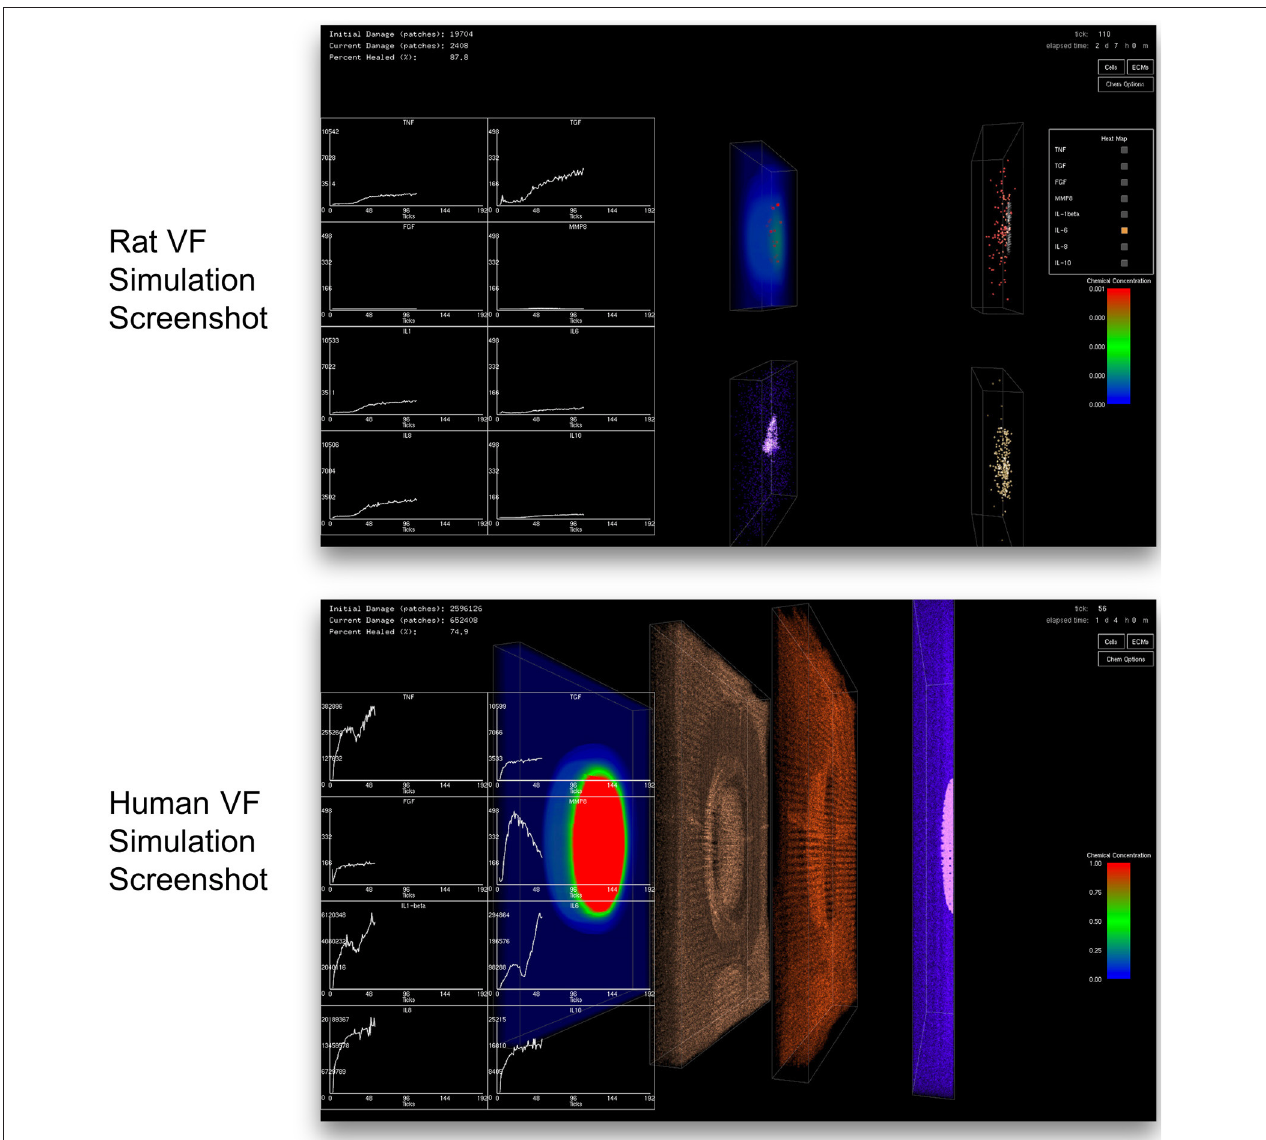
FIGURE 4 | Screenshot of simulation suite captured at the client side. The top and bottom screenshots were taken from the simulations of rat and human vocal fold injury and repair, respectively. In each iteration, only a compressed image is sent over the network instead of sending the whole output data set. This approach allows a fast and efficient transfer of comprehensible outputs to the client. The image transfer costs are the same regardless of the simulation size. Clients only need to install a thin client package to see the visualized results. The 2D charts show total chemical aggregated statistics. Left most 3D volume in human simulation displays the distribution of one of the eight chemicals selected by the user. The second and third volumes show macrophage (brown) and neutrophil (red) distributions, respectively. The last volume on the right displays the tissue damage distribution (pink) and the distribution of fibroblasts (blue). Cell color codes are the same for both rat and human VF-ABM